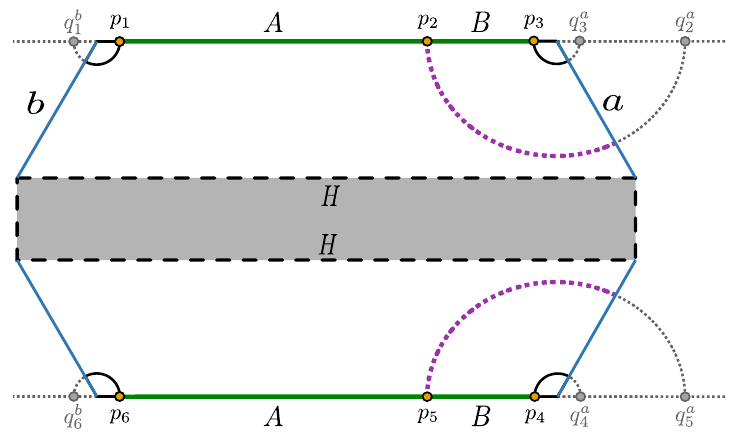
Figure 6 . Here the points and their corresponding mirror images are same as in the previous figure. Additionally, q a = 2 r O − r and q a = 2 r O − r are the mirror images of the points p 2 = r and 2 5 p 5 = r with respect to the a -boundary at p O = r O .